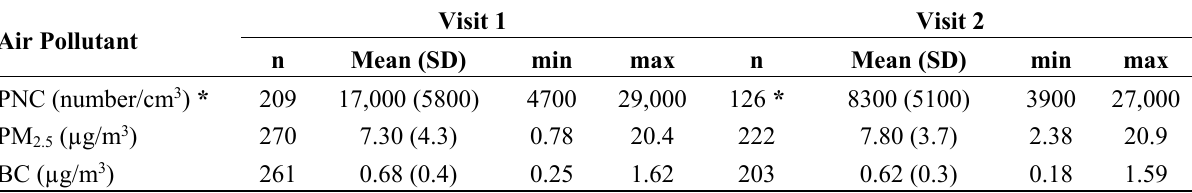
Table 3. Summary statistics of mean air pollutant concentrations in Boston, Massachusetts.